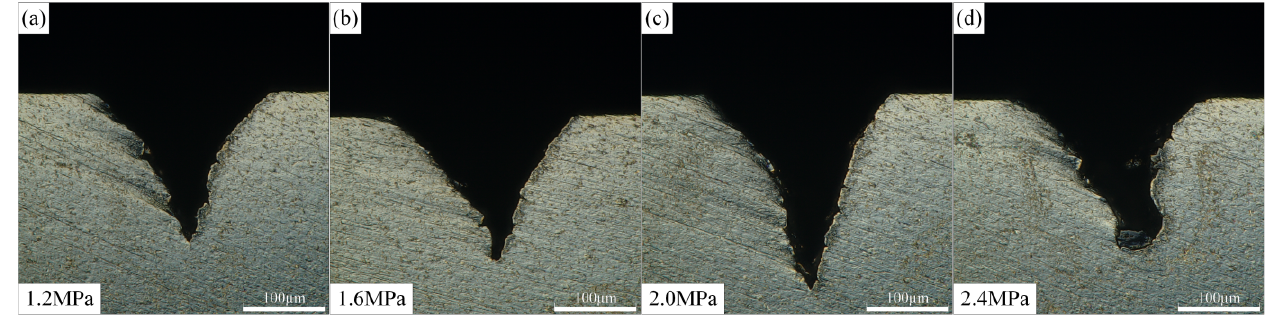
Figure 10. Effect of water pressure on microgroove morphology. ( a ) Water pressure is 1.2 MPa, ( b ) Water pressure is 1.6 MPa, ( c ) Water pressure is 2.0 MPa,( d ) Water pressure is 2.4 MPa.